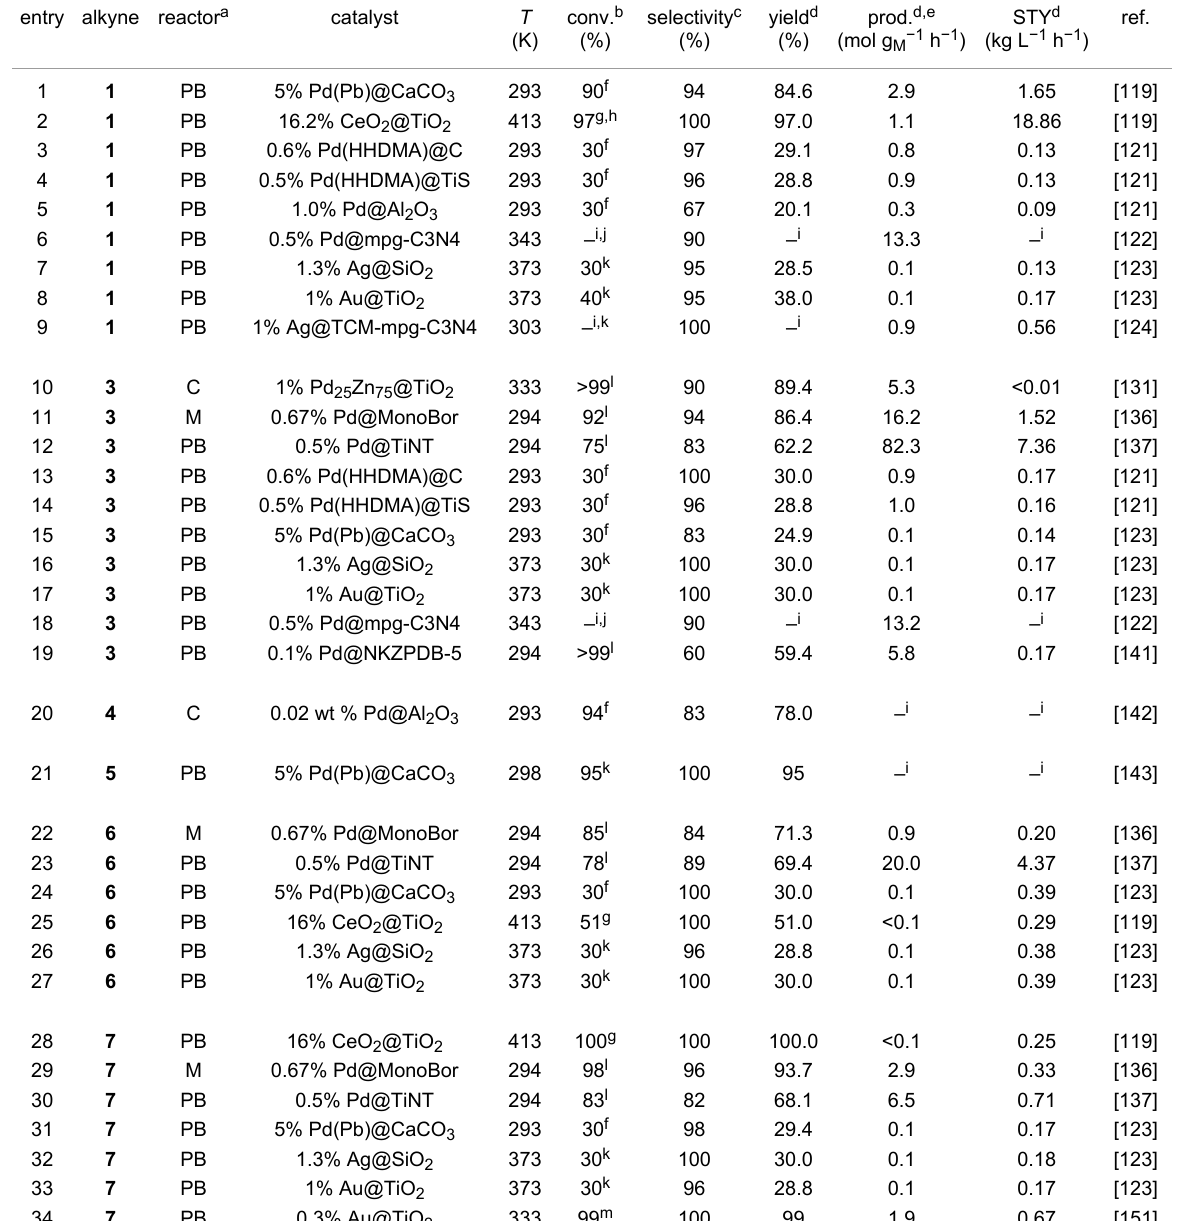
Table 1: Representative continuous flow catalytic processes for liquid-phase partial hydrogenation of terminal alkynes. entry alkyne reactor